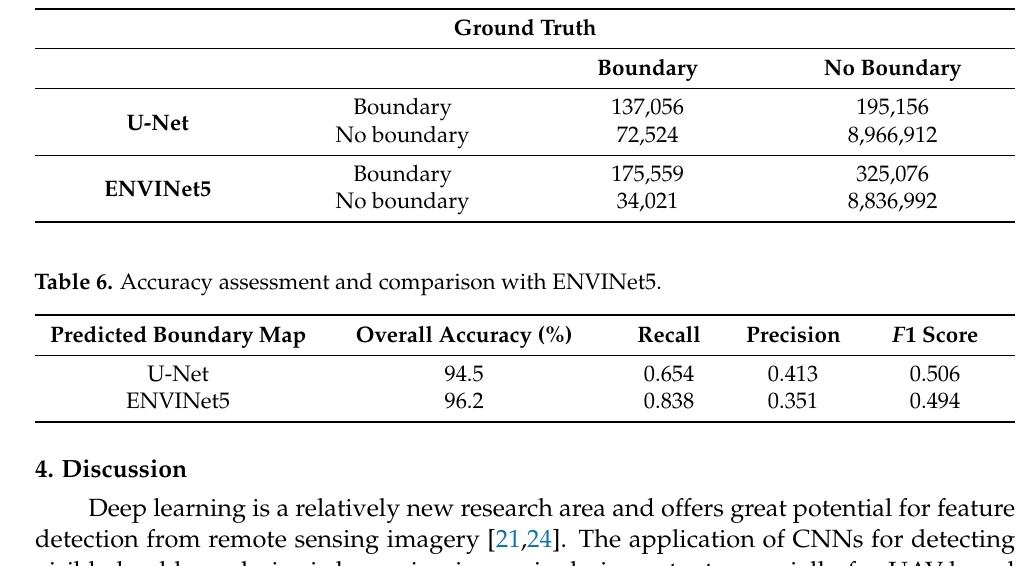
Table 5. Confusion matrices based on the number of pixels.